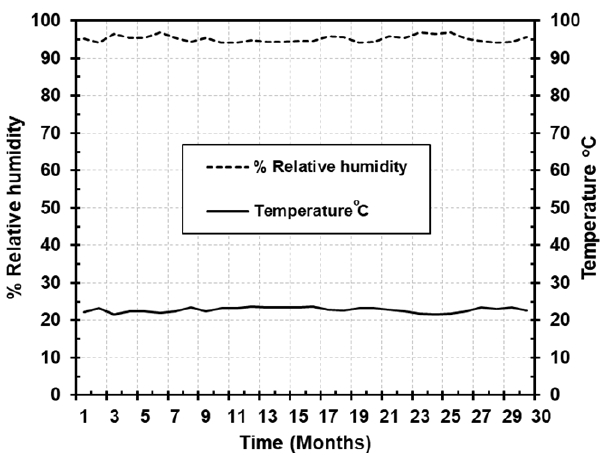
Figure 3. Moisture exposure (relative humidity and temperature) over time.